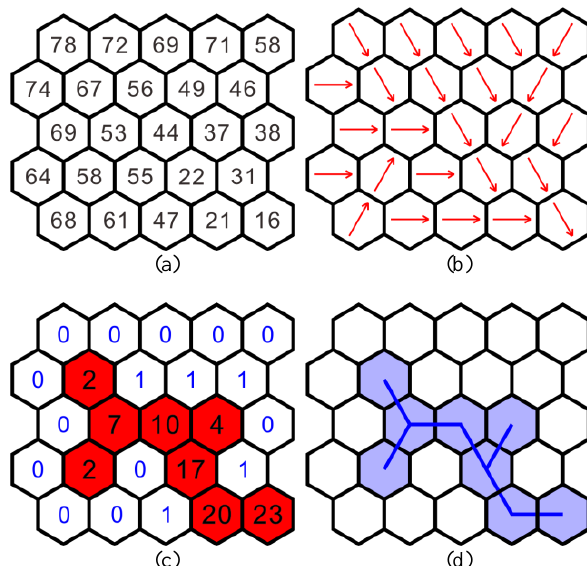
Figure 4. The schematic diagram of drainage networks extraction based on D6 algorithm: (a) the elevation data; (b) the estimated result of flow direction displayed by arrows; (c) the calculated result of flow accumulation; (d) the result of extraction with accumulation threshold of 2.